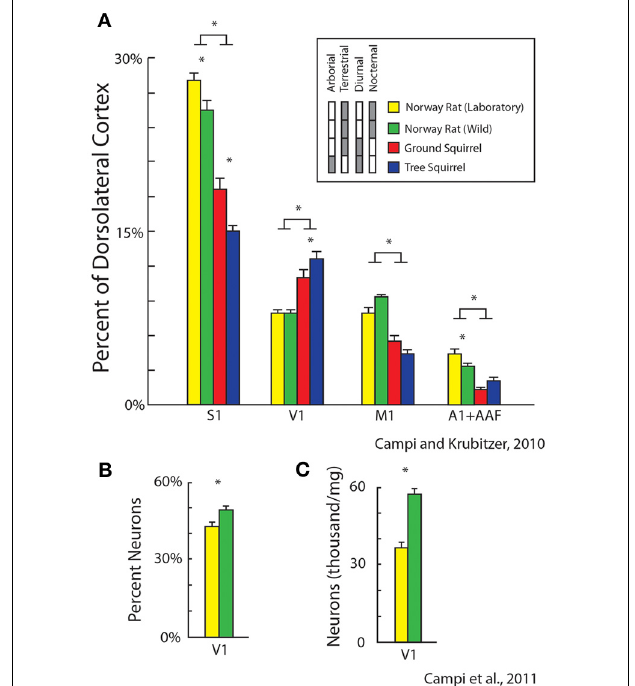
FIGURE 9 | Alterations in the relative size of primary cortical areas (A) and cellular composition (B,C) between different populations of rodents. These features of organization are related to lifestyle (diurnal vs. nocturnal; arboreal vs. terrestrial) and rearing condition (laboratory, yellow vs. wild-caught, green). Bars represent mean ± standard error, asterisks represent statistical significance. Modified from Campi and Krubitzer (2010) (A) ; Campi et al. (2011) (B,C)